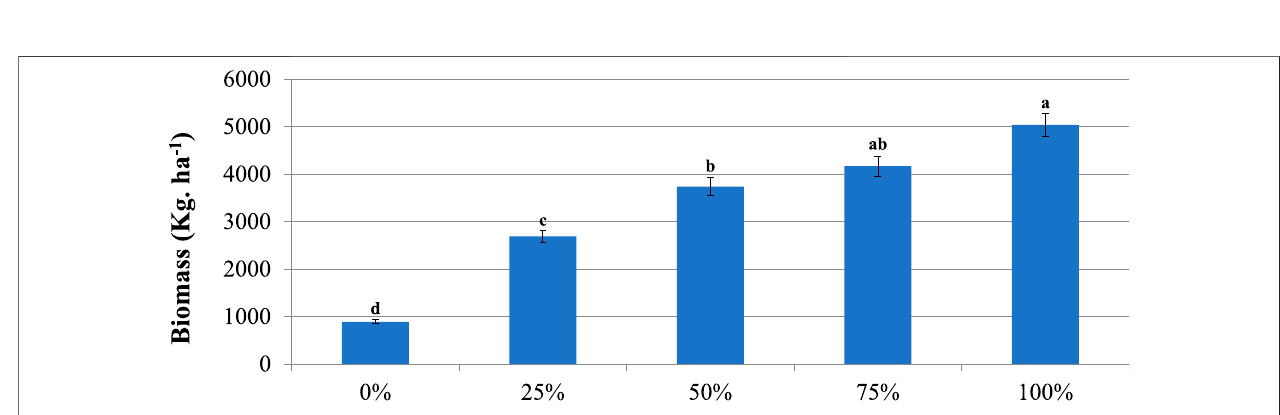
FIGURE 3 | The effect of thinning on grass biomass in the communal grazing lands of southern Ethiopia. % (cid:2) thinning plot. Signi fi cance differences between plots are indicated by different letters. Vertical bars mean a 0.95 con fi dence interval.